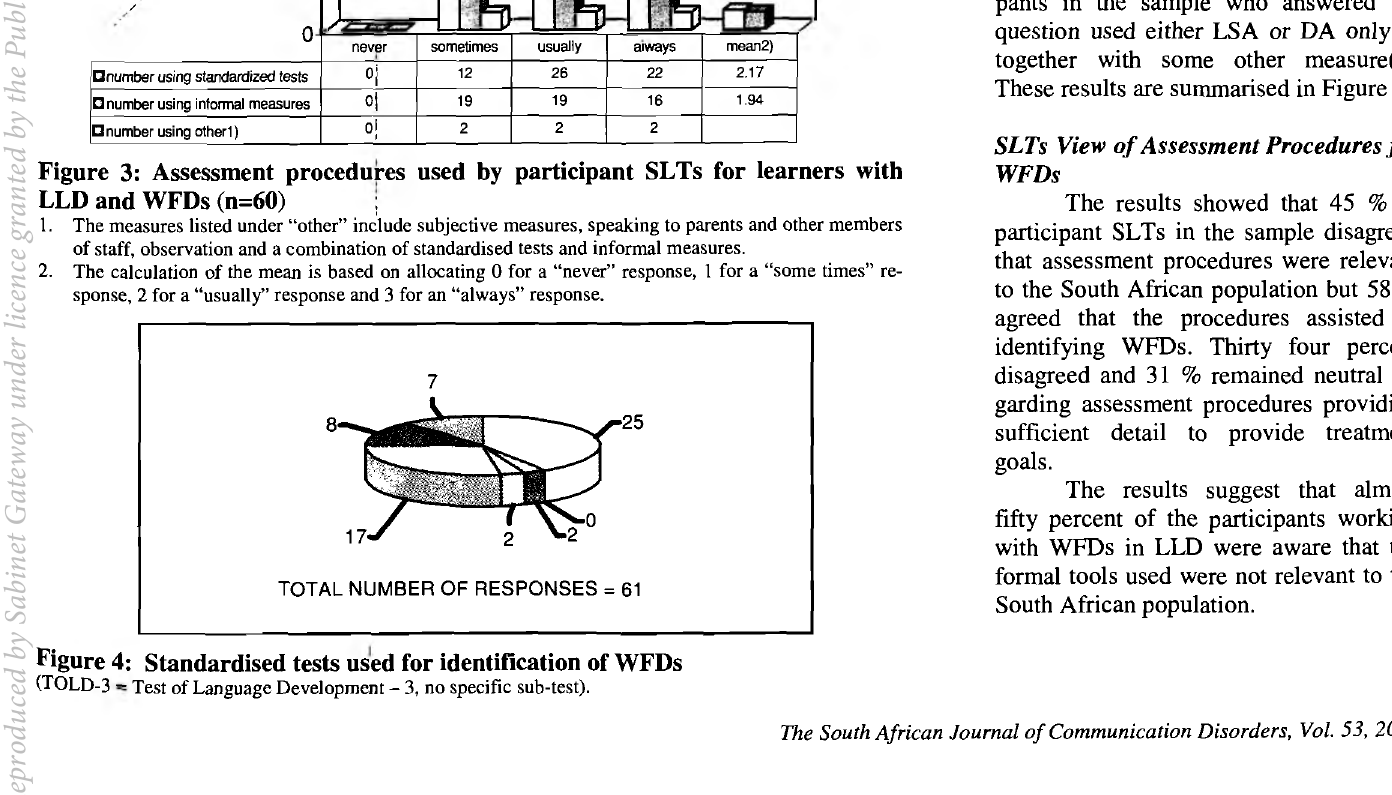
Figure 4: Standardised tests used for identification of WFDs (TOLD-3 - Test of Language Development - 3, no specific